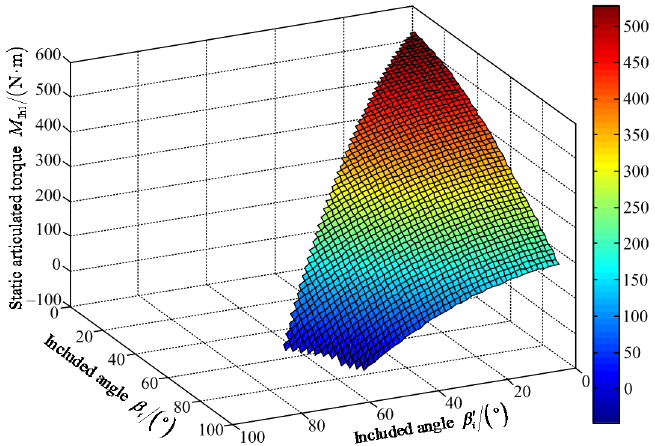
I z 1 with changes of β i ′ and β i .